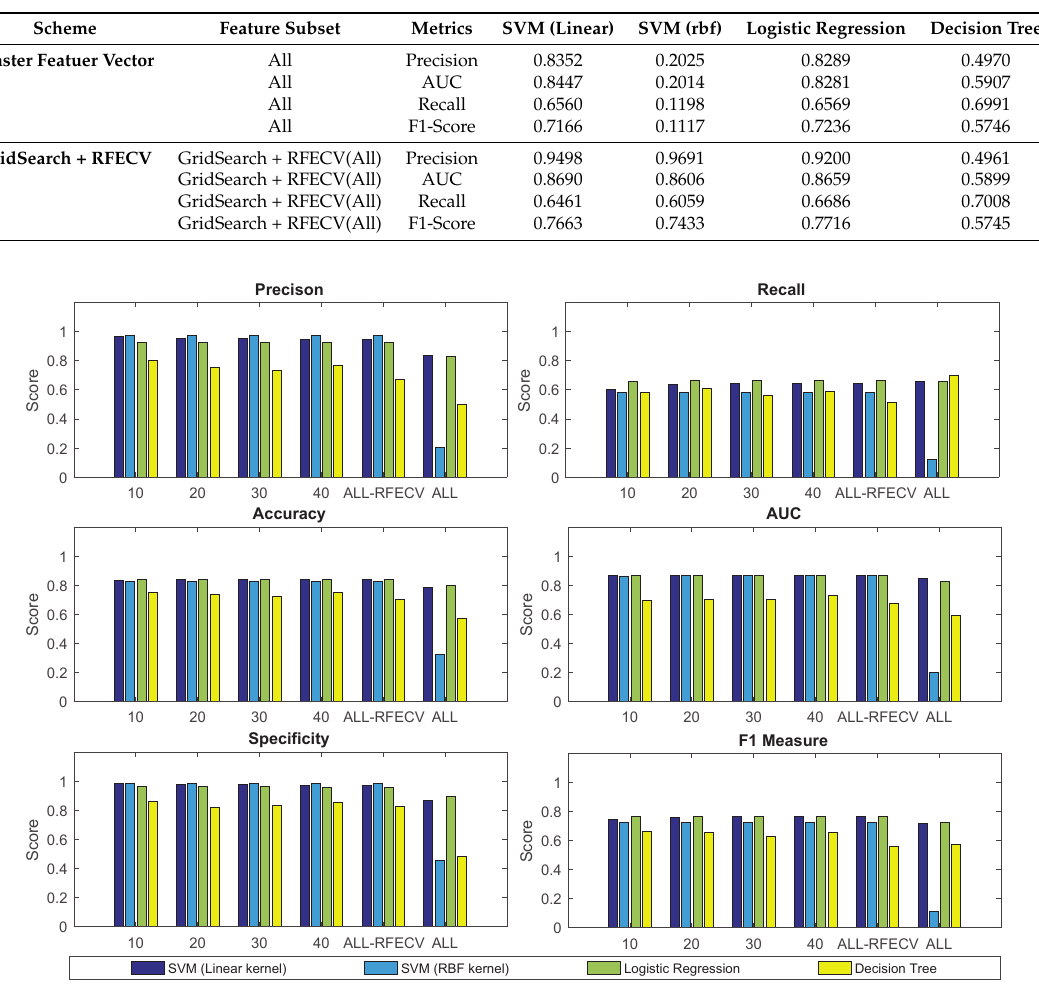
Figure 4. Comparative results of various machine learning classifiers on different features subset obtained as the result of applying GridSearch (for parameters tuning), RFECV feature selection scheme, and Information Gain (IG) feature selection